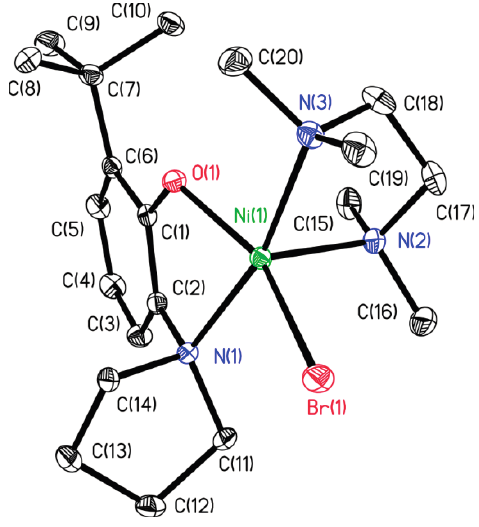
Figure 4. ORTEP diagram of 7 . All hydrogens are removed for clarity. The one non-disordered molecule of the asymmetric unit is shown. Selected bond lengths (Å):